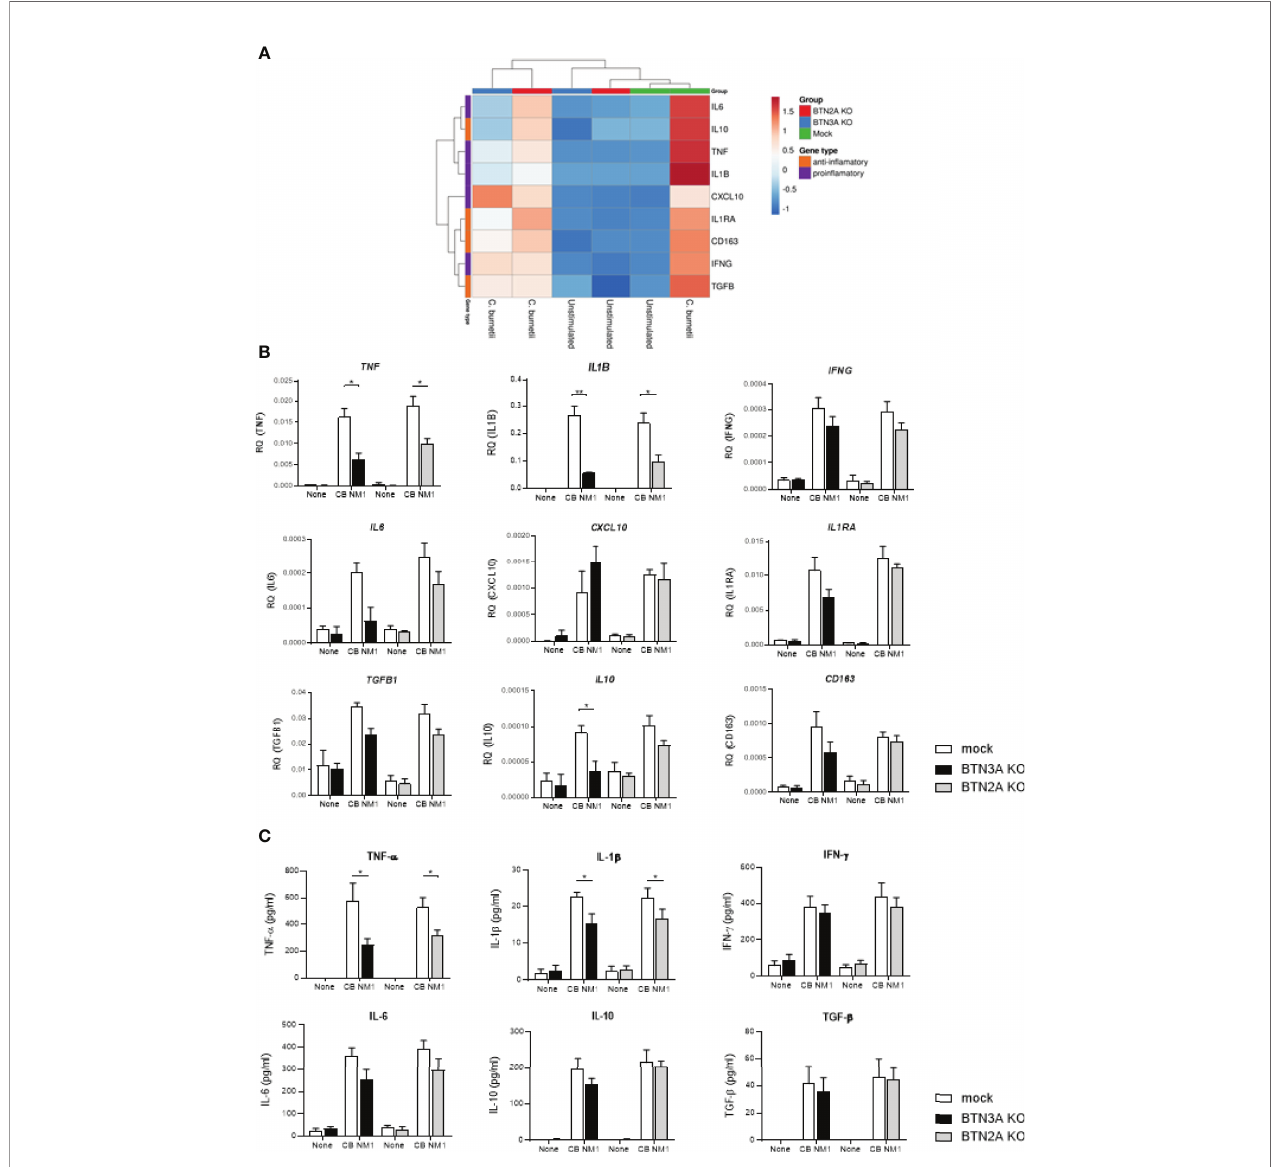
FIGURE 3 | Involvement of BTN3A and BTN2A in the in fl ammatory response to C. burnetii infection. THP-1 cells transduced with an irrelevant CRISPR guide (mock) or a guide targeting all BTN2A isoforms (BTN2AKO) or all BTN3A isoforms (BTN3AKO) were infected with C. burnetii NM1 (100 MOI) (n = 3). After 24 hours infection, the expression of genes involved in the in fl ammatory ( TNF , IL1B , IL6 , IFNG , CXCL10 ) or immunoregulatory ( IL10 , TGFB1 , IL1RA , CD163 ) response was investigated by quantitative reverse-transcription polymerase chain reaction after normalization with housekeeping actin gene as endogenous control. Data are illustrated as (A) hierarchical clustering obtained using ClustVis webtool or (B) relative quantity of investigated genes. (C) After 24 hours infection, TNF- a , IL-1 b , IFN- g , IL-6, IL-10, and TGF- b release were evaluated in the culture supernatants by ELISA assay. Data were analyzed using a normality test and a parametric t test. Values represent mean ± standard error. * p < 0.05 and ** p < 0.01